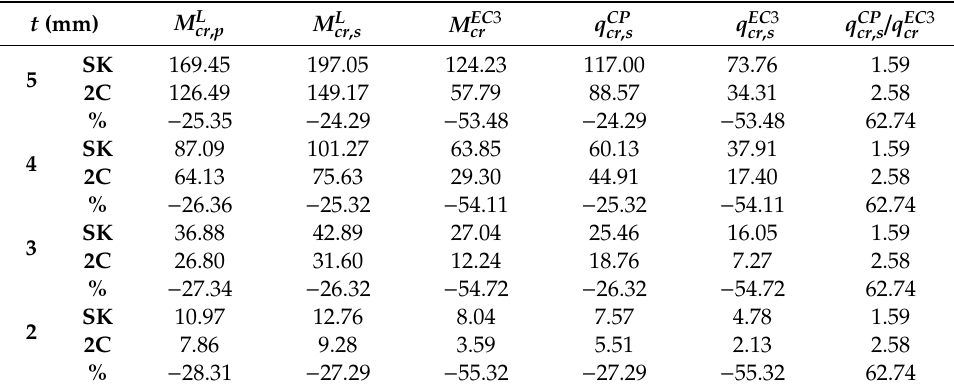
Table 8. Comparison of “local” critical resistances of box sections (Sk) and compound I-sections (2C) depending on the wall